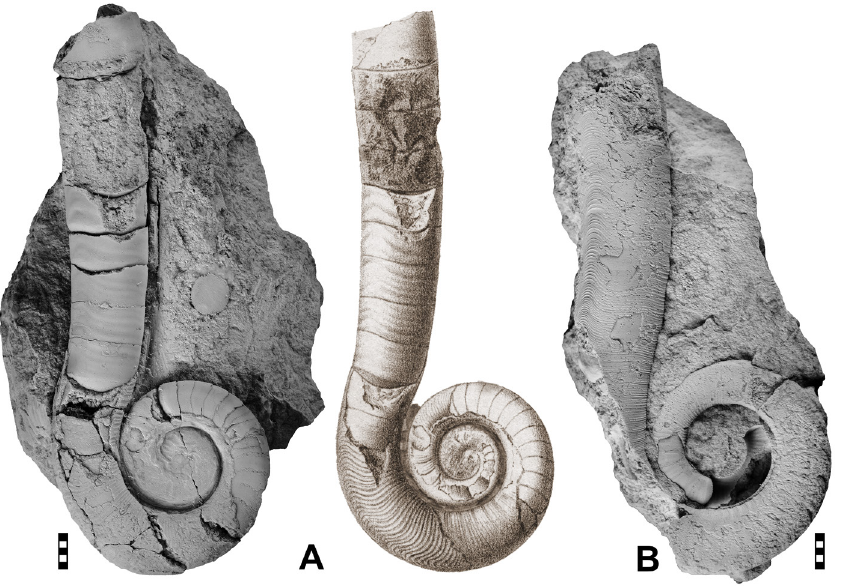
Fig. 50. Lituites tenuicaulis Remelé, 1890 from the Upper Grey Orthoceratite Limestone. A .